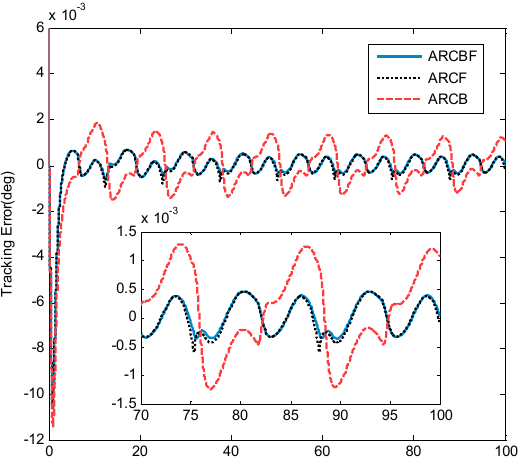
Figure 3. The position tracking of ARCBF as ε = 1 × 10 − 6 .